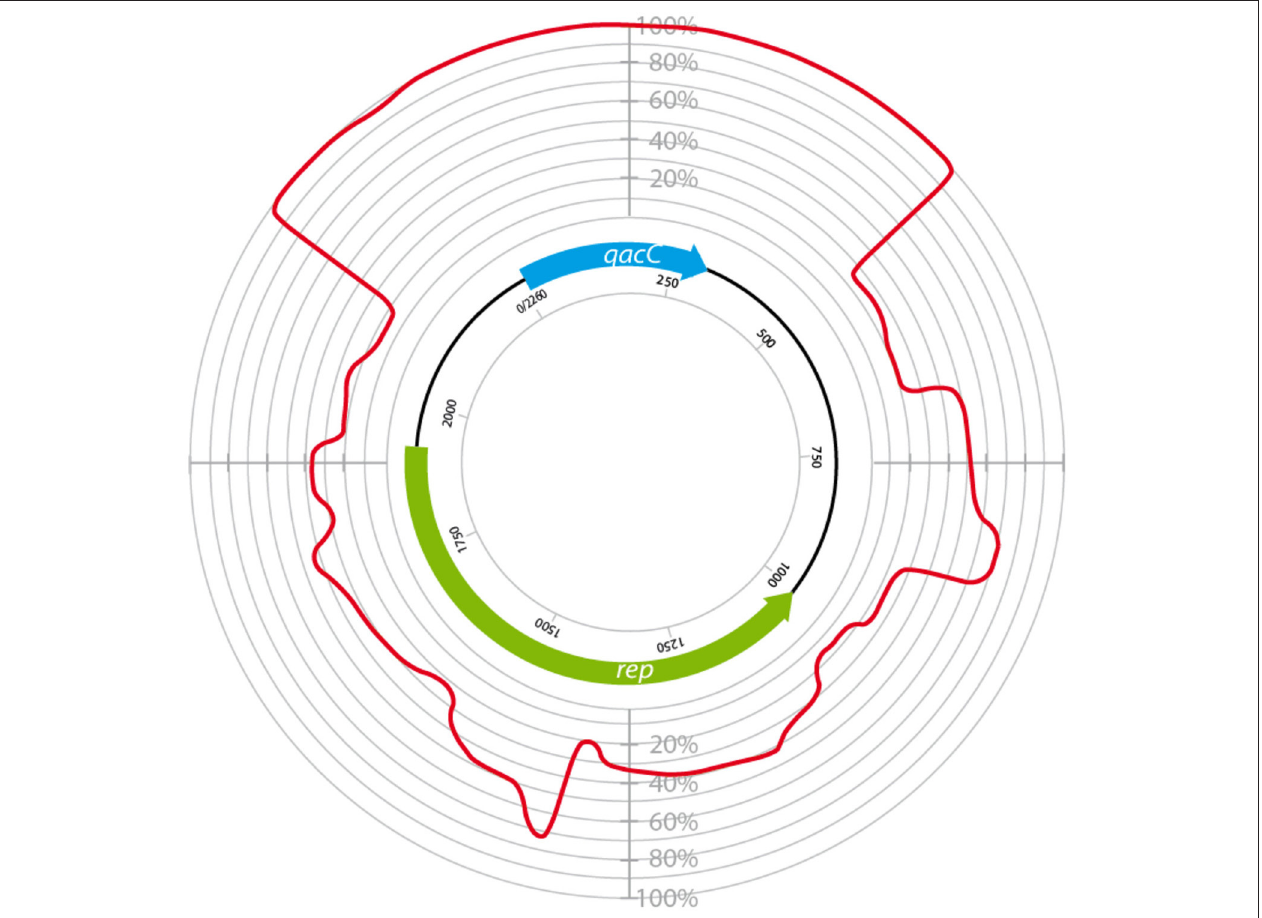
FIGURE 1 | Circular homology plot based on the nucleotide alignment between QacC plasmids. The figure is based on an alignment after gap removal of pNVH99, pWBG754, pSA1308, pLUH01, pKH8, pSH4126, pPI-2, pSW49, pSK89, pWBG32, pSepCH, and pSM52, which were reopened for alignment at the start of qacC . The indicated length of rep is the average of the analyzed